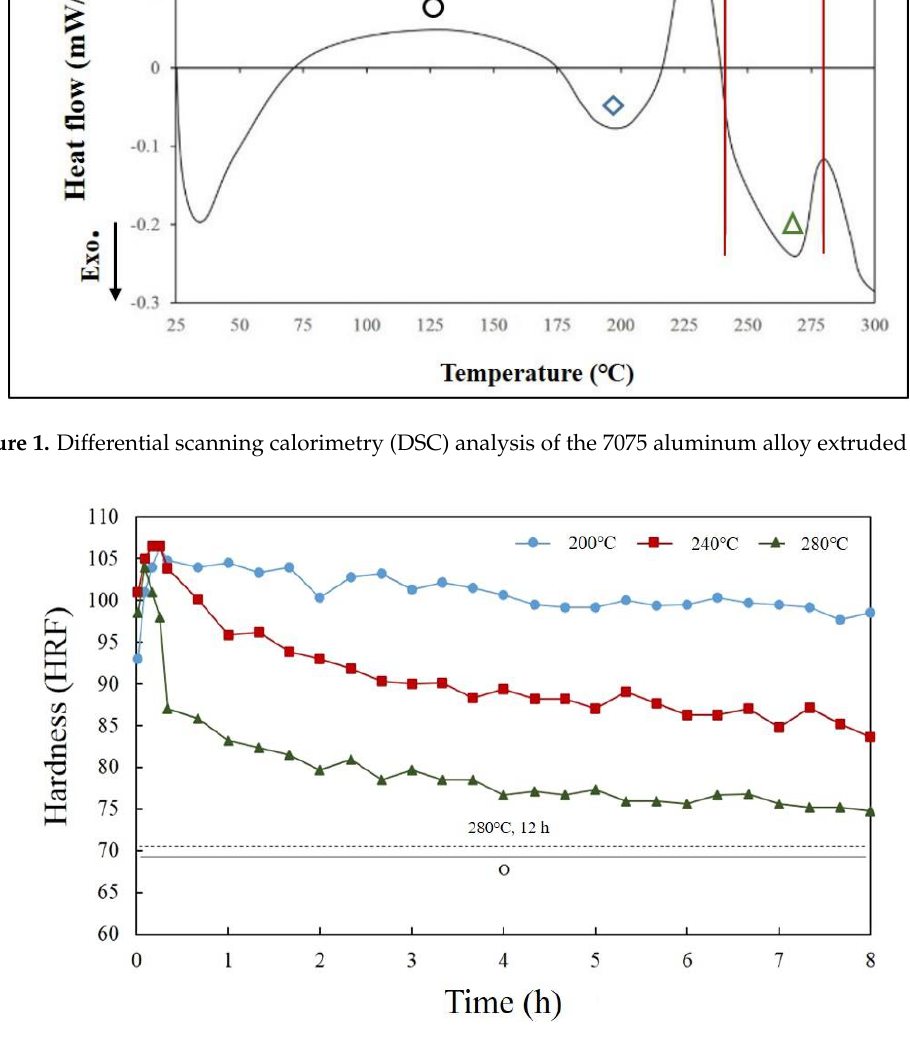
Figure 2. The aging hardness curves of the 7075 aluminum alloy extruded rod during different treatments.